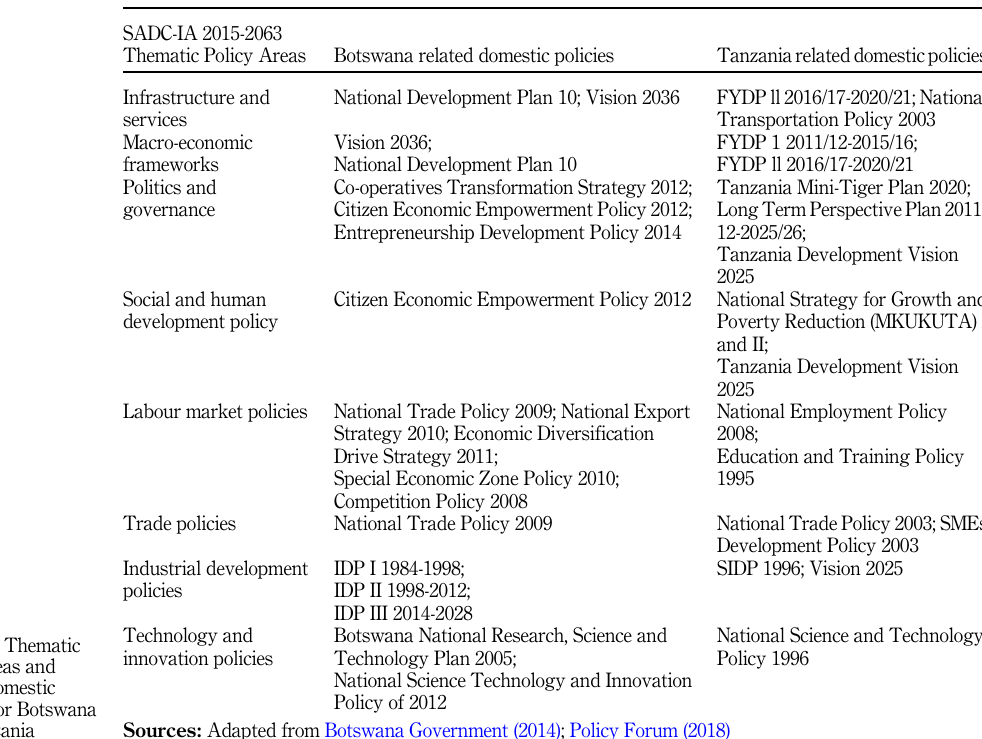
Table 2. SADC-IA Thematic policy areas and related domestic policies for Botswana and